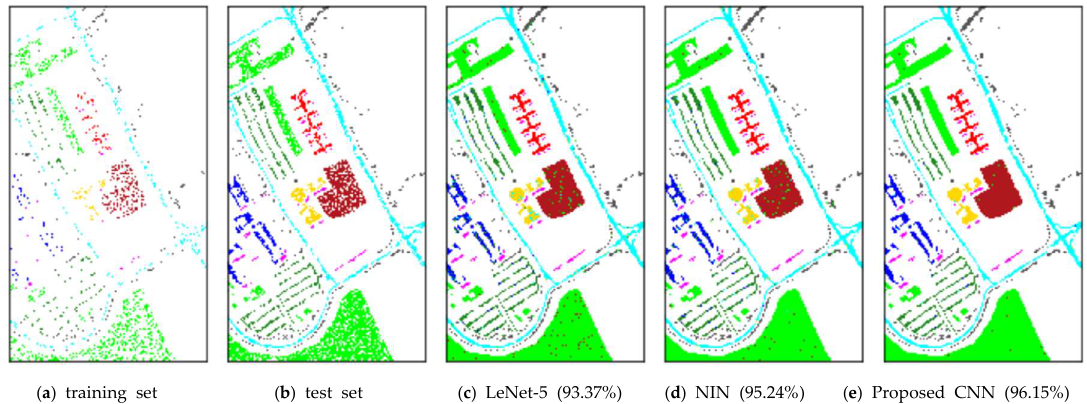
Figure 17. Classification maps of different CNN architectures on the Pavia University dataset.